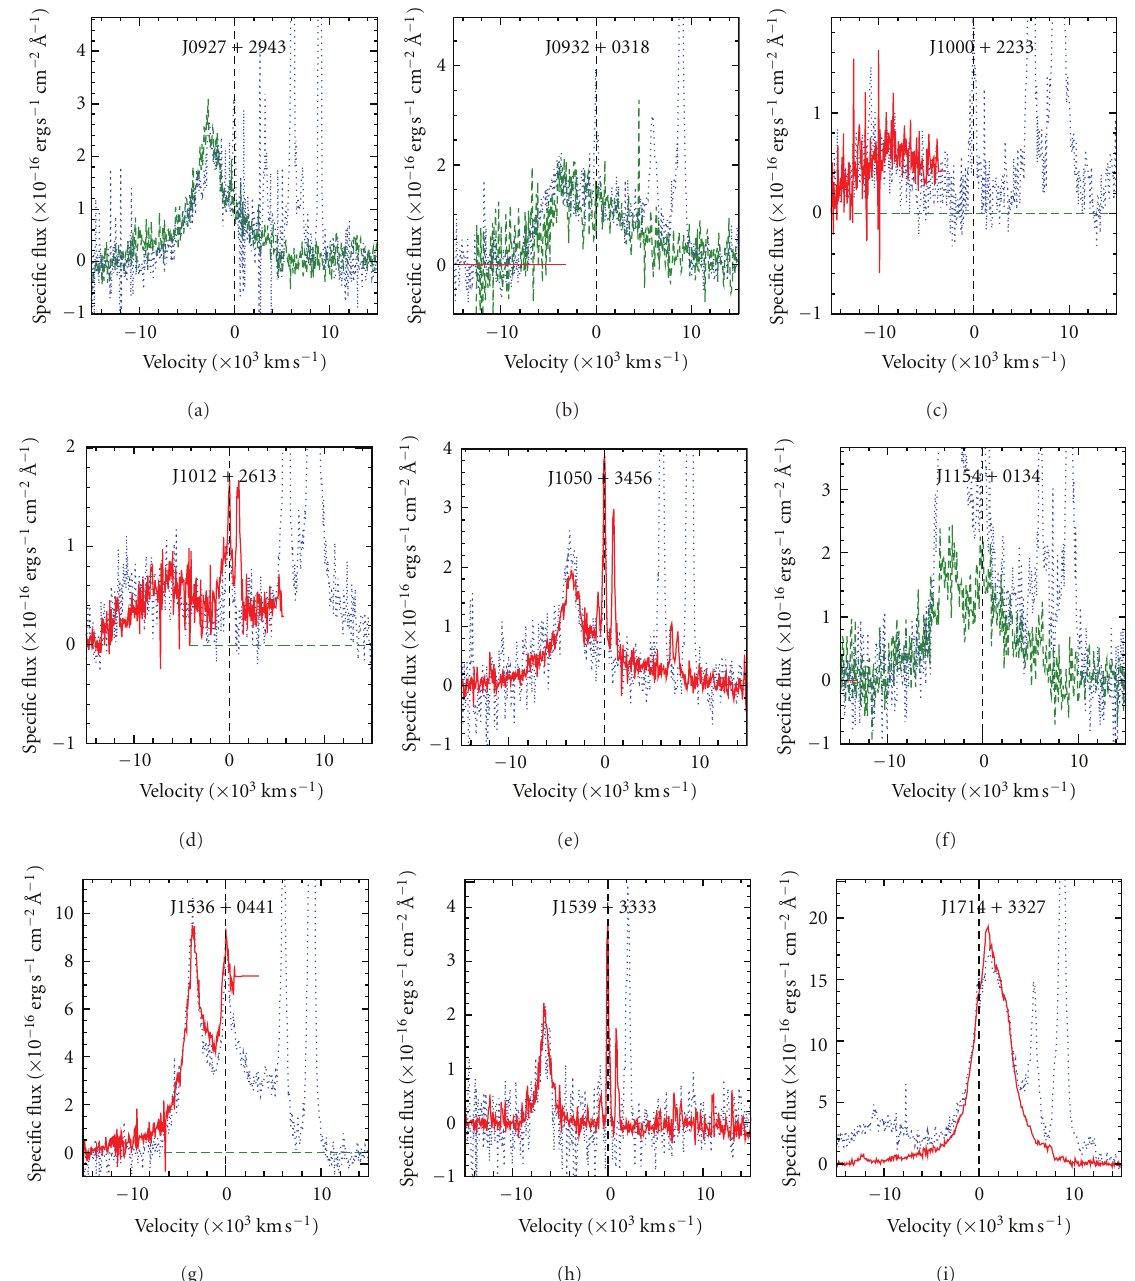
Figure 3: Velocity diagrams of H α (red, solid lines), H β (blue, dotted lines), and MgII (green, dashed lines) for all the spectroscopically identified MBHB candidates. The flux of H β is scaled up to match the one of H α or MgII. Adapted from Tsalmantza et al.